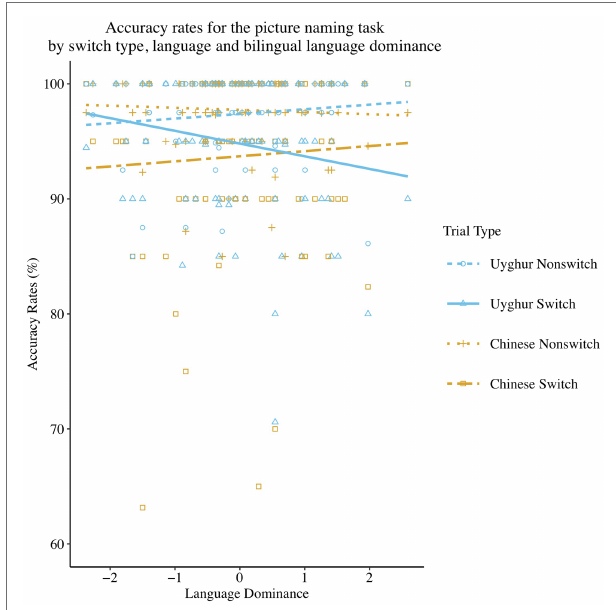
FIGURE 1 | Scatterplot and regression fit lines showing the correlation between Language Dominance and mean accuracy rates at each level of the combinations of Switch Type and Language in the picture naming task.